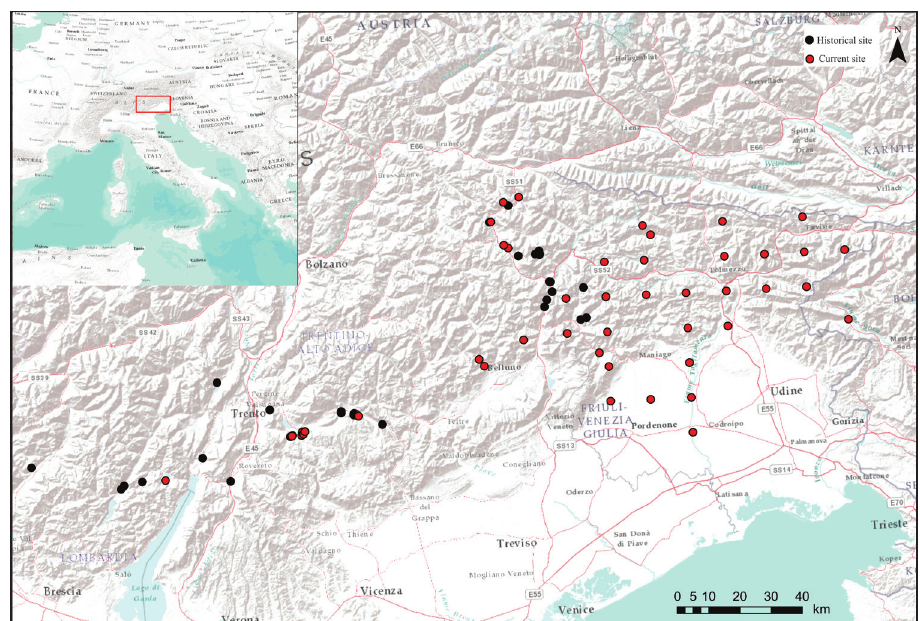
Figure 4. Geographic range and distribution map of Chondrilla chondrilloides in Italy (black dots: histori- cal sites not recently confirmed; red dots: current/confirmed sites). many, Austria, and Slovenia. Some of the Italian sites (33%) are included in the Natura 2000 protected areas